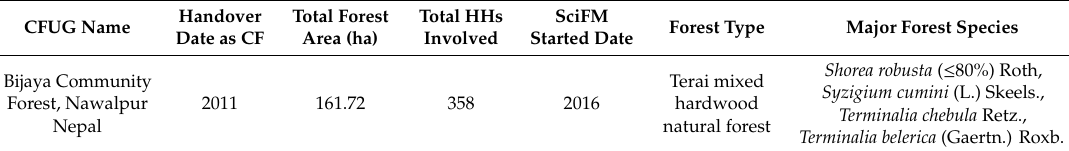
Table 1. Description of the study